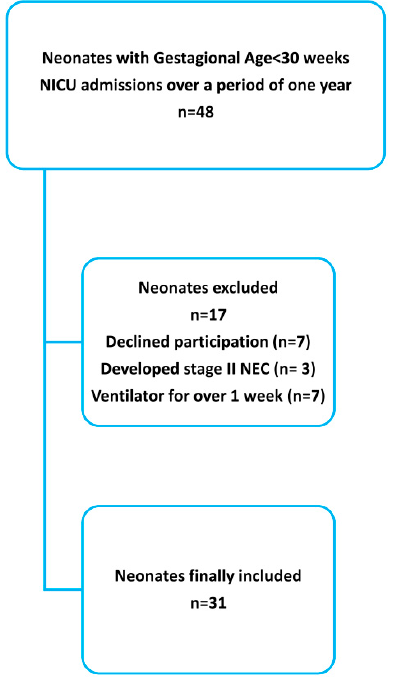
Figure 1. Flow chart of study population.